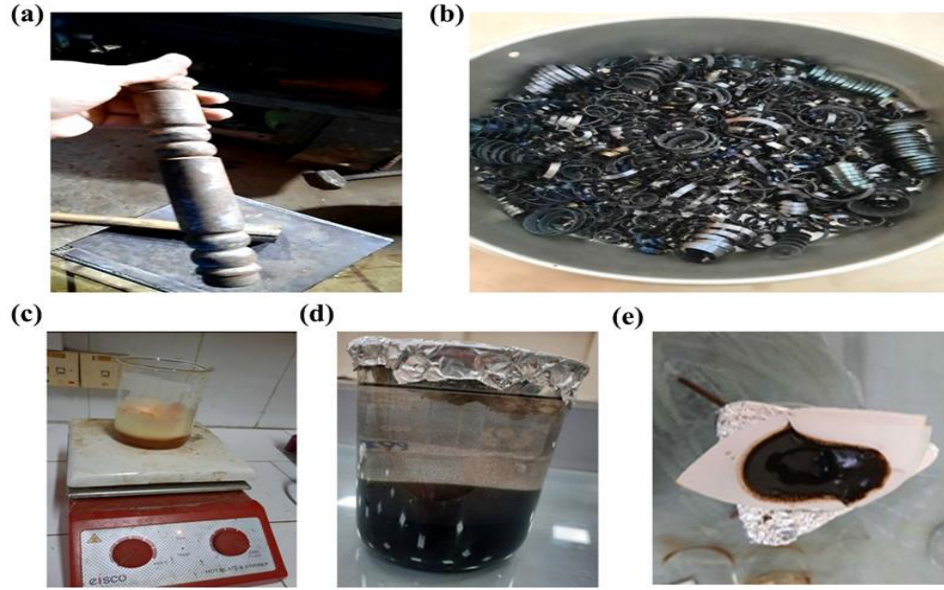
Figure 1. Synthesis illustration, ( a ) iron rod, ( b ) scrap iron, ( c ) solution of copper chloride and iron chloride, ( d ) precipitates of CDF, and ( e ) precipitates of iron oxide.